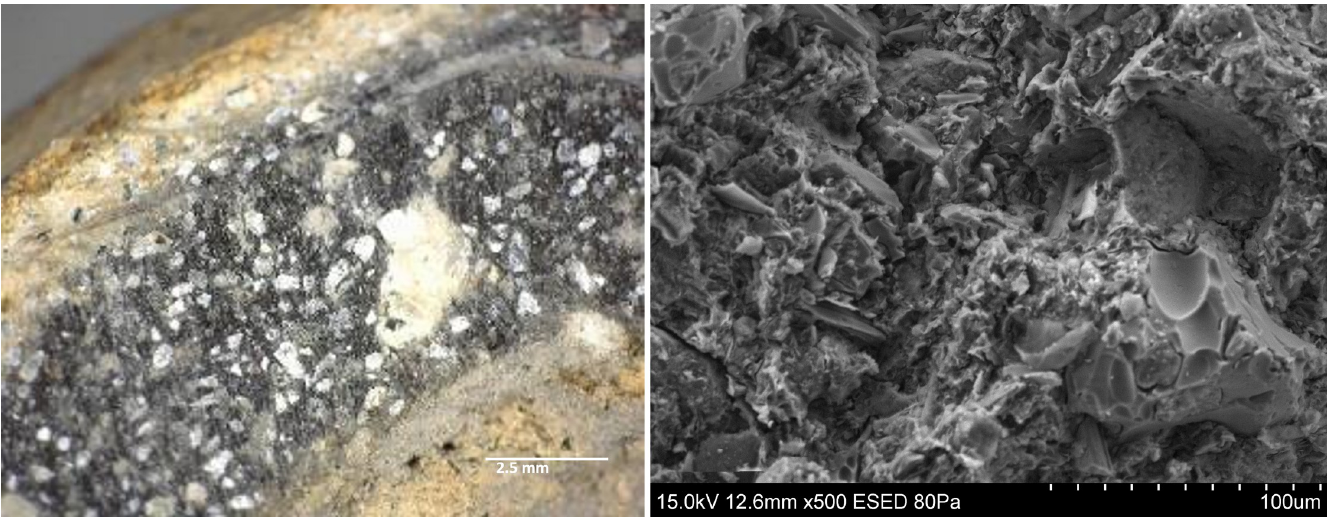
Fig 12. Micro and macrostructural evidence of heat treatment in sample IN01. A. Cross section showing the complete section with bright edges and a dark core. B. SEM image showing the microstructure without vitrification.